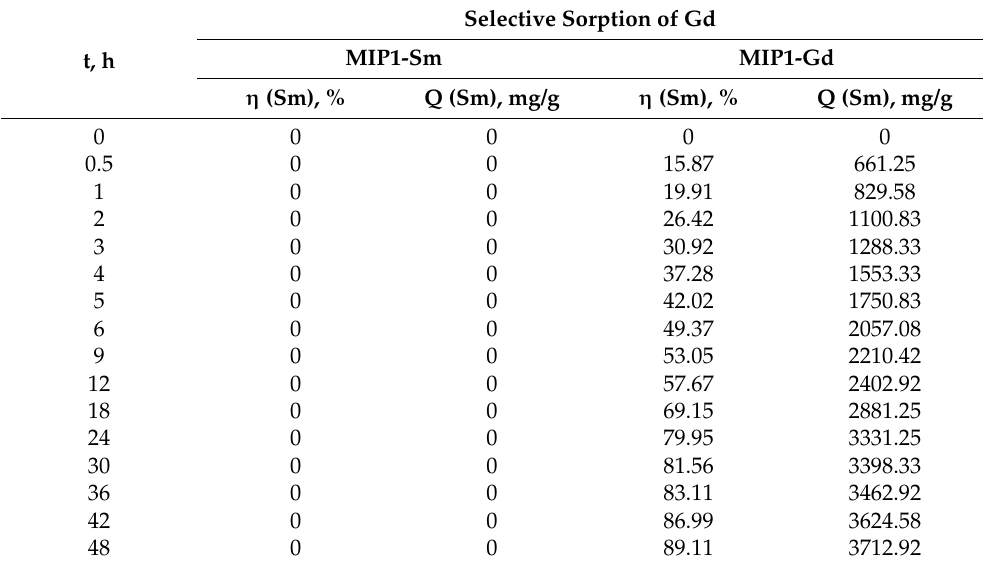
Table 9. Sorption properties of the MIP1-Sm and MIP1-Gd structures during selective sorption of gadolinium.